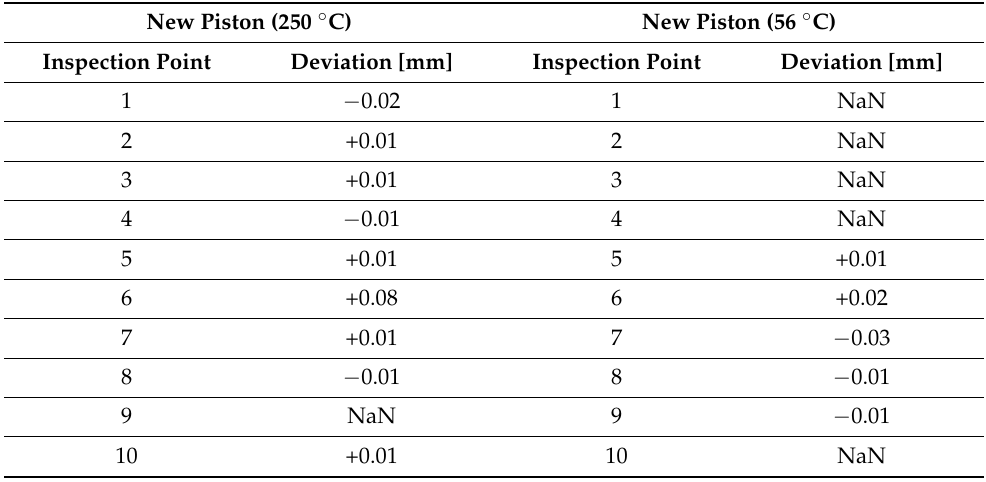
Table 2. Example results of the deformation of the new piston during the cooling process (NaN—data not available (deviations not determined) as a result of reflexes and thermal radiation leading to static disadvantages for optical measurement systems).